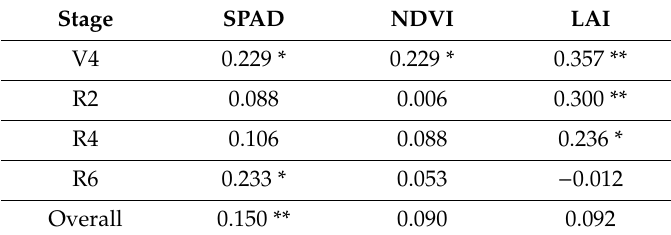
Table 2. Correlation coe ffi cient of SPAD, Normalized Di ff erence Vegetation Index (NDVI), and leaf area index (LAI) traits at di ff erent stages with fertilization